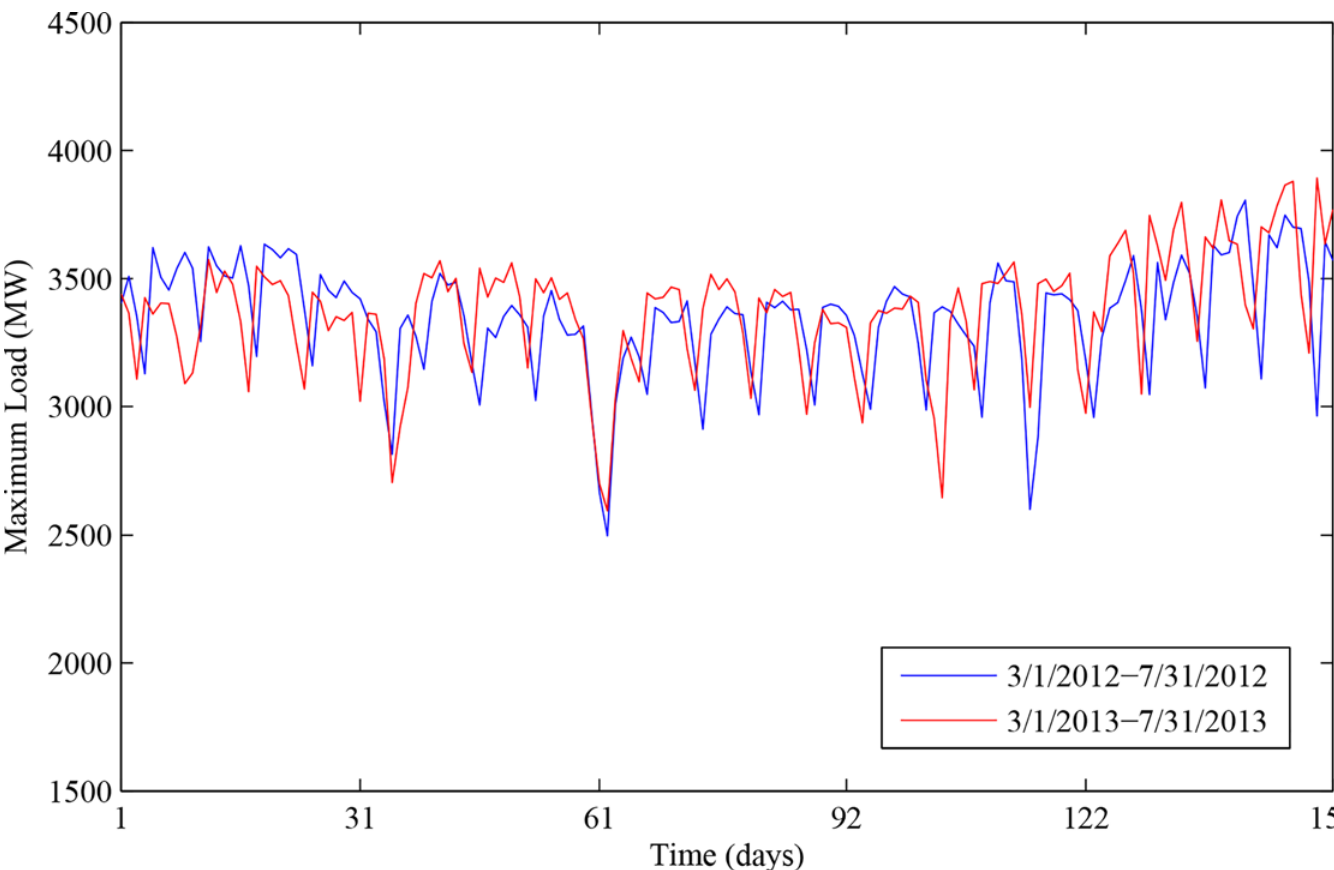
Fig 2. The month characteristic of daily maximum load. The blue line represents the maximum load from March 1st of 2012 to July 31st of 2012. The red line represents the maximum load from March 1st of 2013 to July 31st of